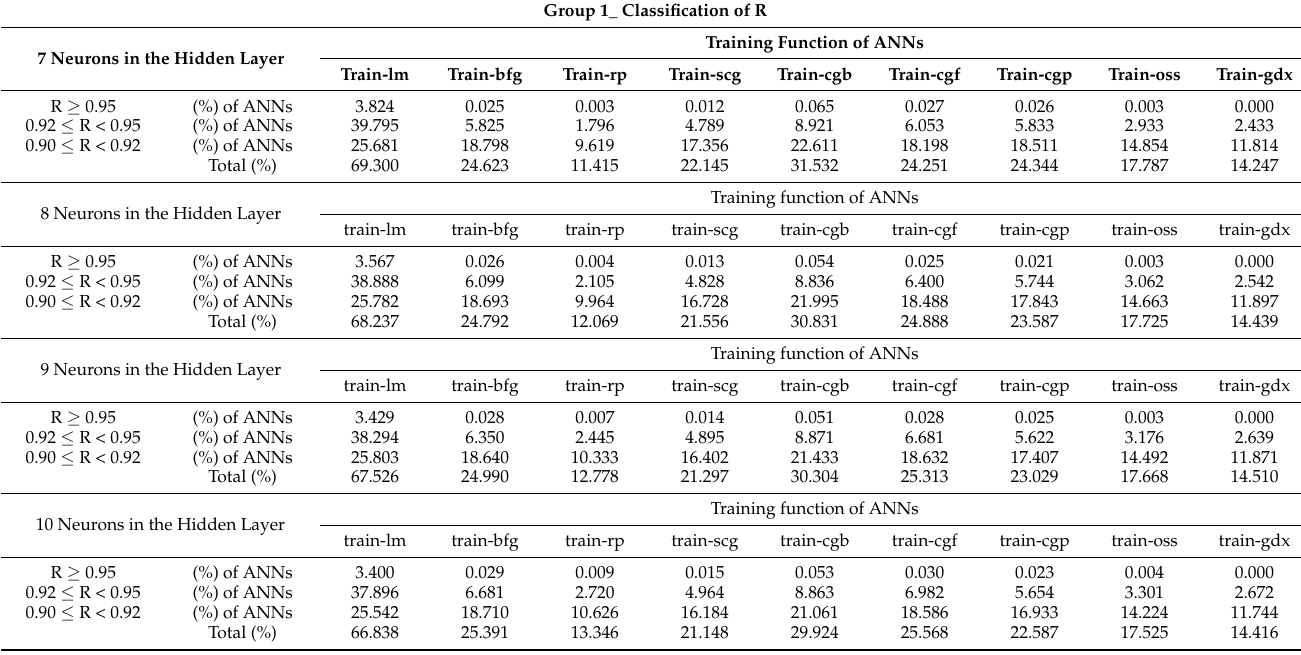
Table 8. Classification of R—ANNs with input parameters of Group